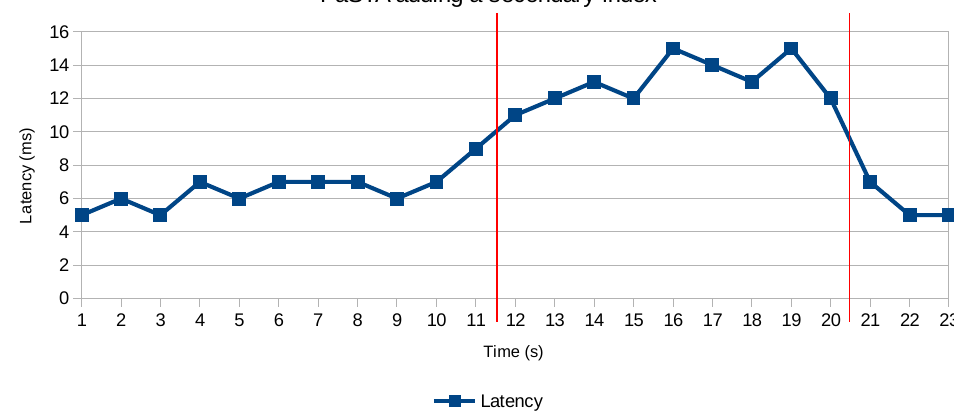
Figure 12. Time required before secondary index becomes effective.